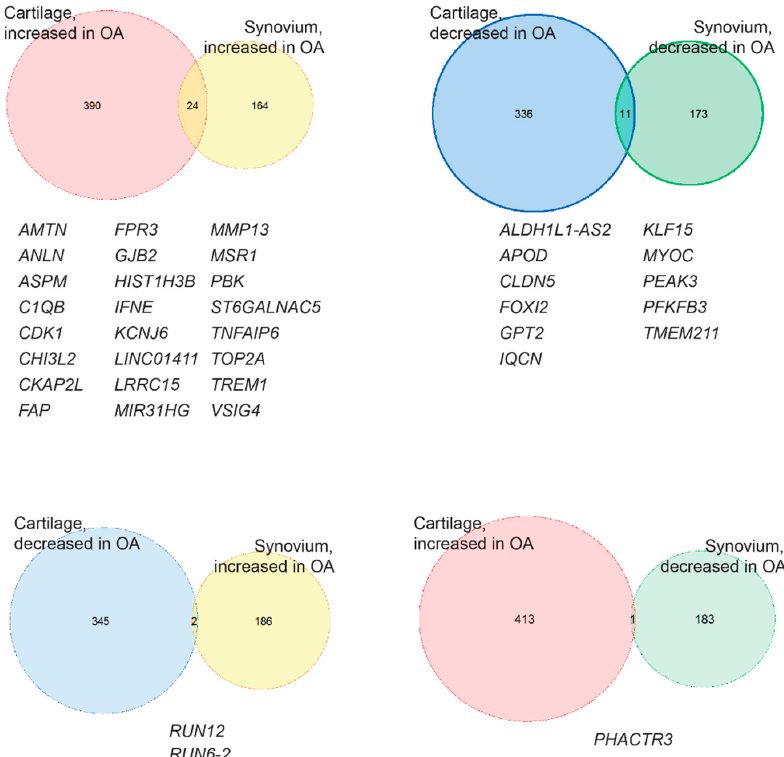
Figure 3. Venn diagrams visualize the osteoarthritis (OA)-responsive differential expressed genes (DEGs) with the same or different expression trends in cartilage and synovium. AMTN — Amelotin ;